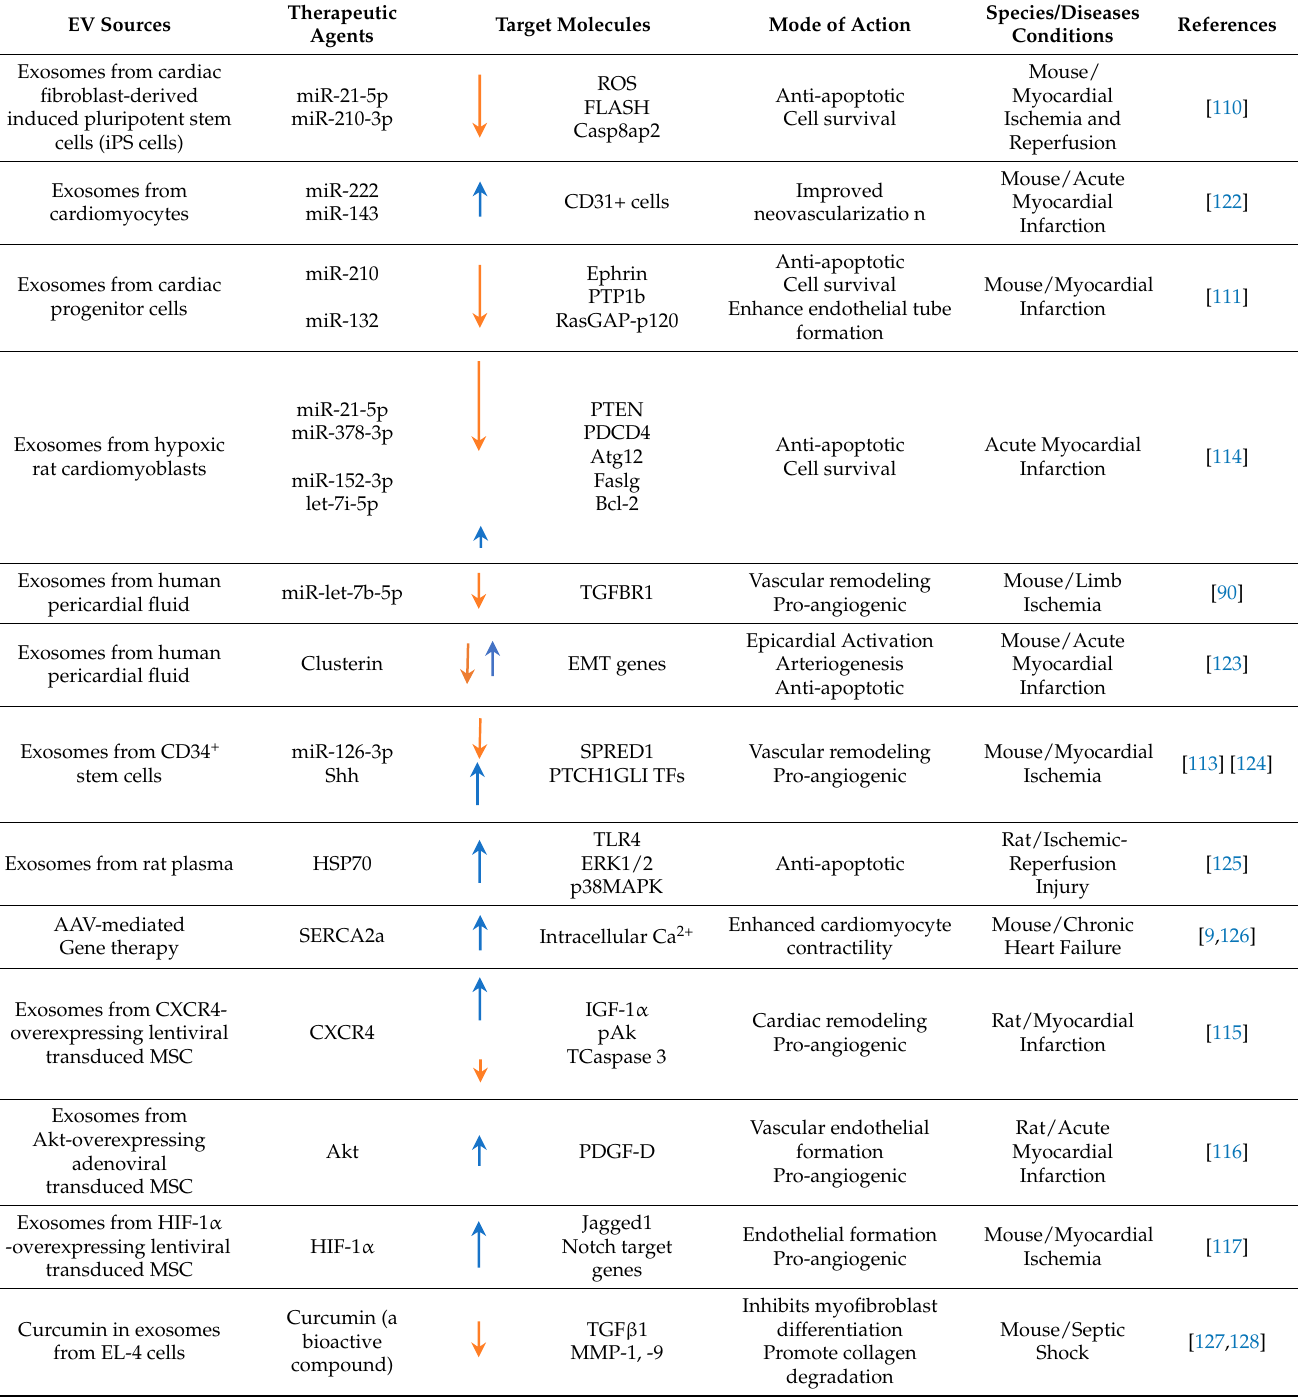
Table 1. Studies employing exosomes with or without modification for treatment of cardiovascular disease (CVD). Up- or down-regulation of target molecules is symbolized by red or blue arrows respectively.